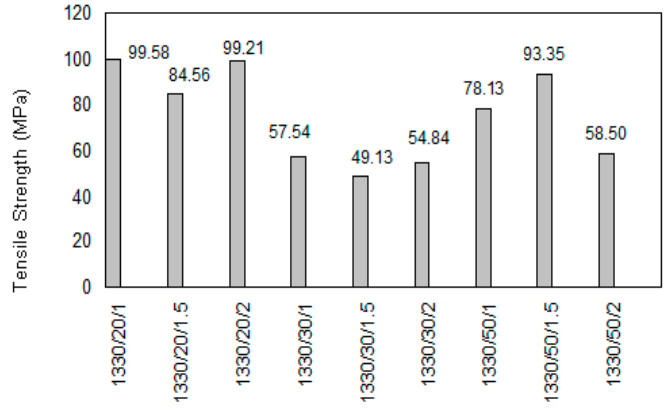
Figure 7. Tensile test results of 1330 rpm.